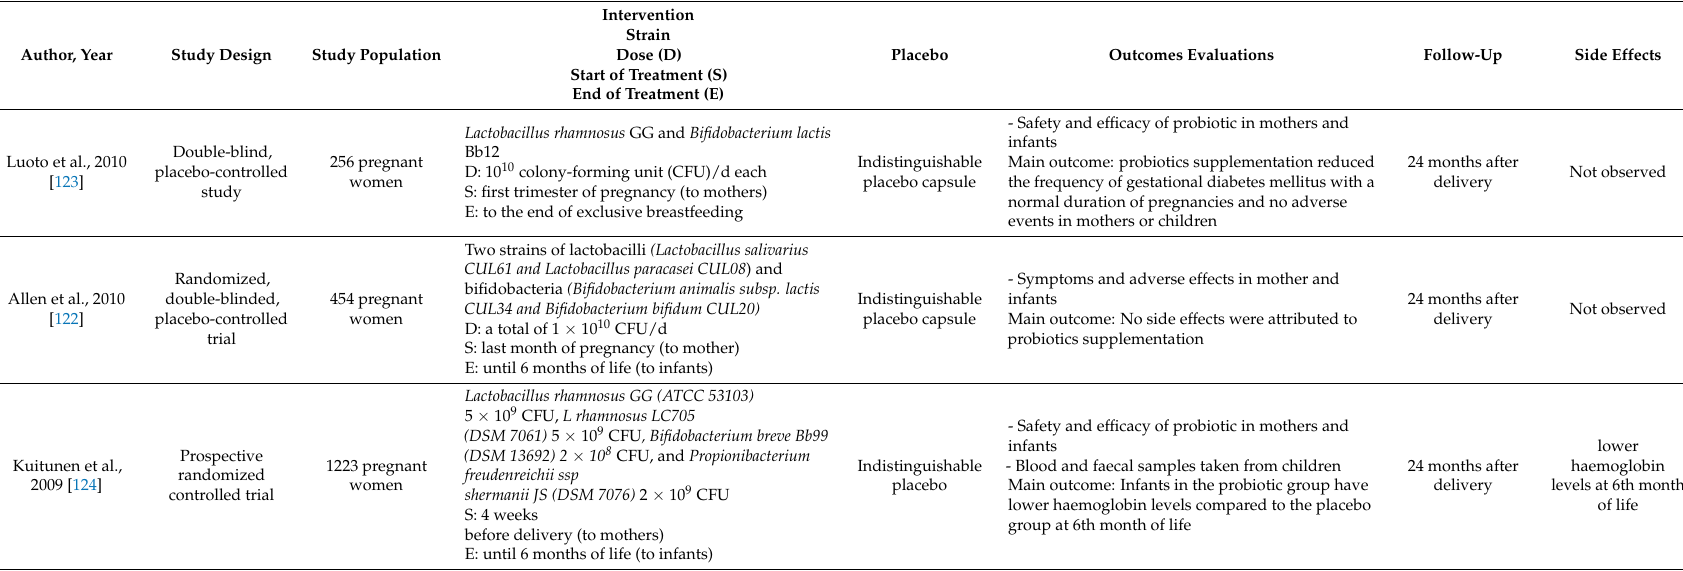
Table 4. Safety of probiotics in pregnancy and neonatal